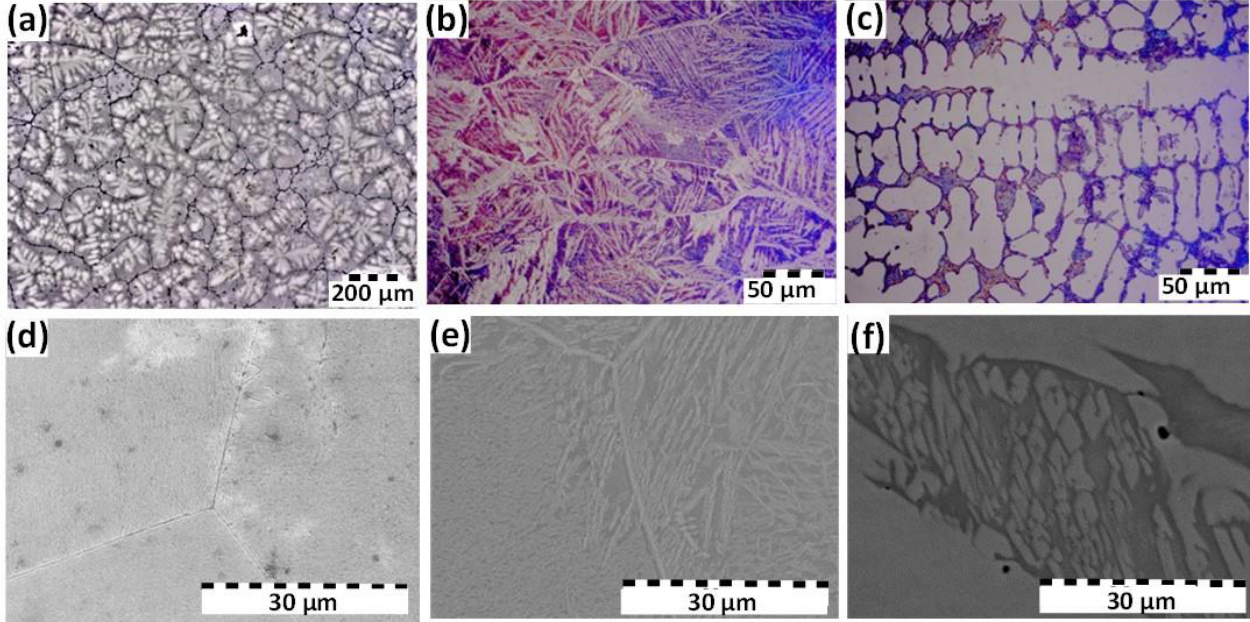
Figure 1. Metallographic microscopy and SEM images for Al 1.0 CrFeCoNi ( a , d ), Al 0.8 CrFeCoNi ( b , e ), and Al 0.6 CrFeCoNi ( c , f ).